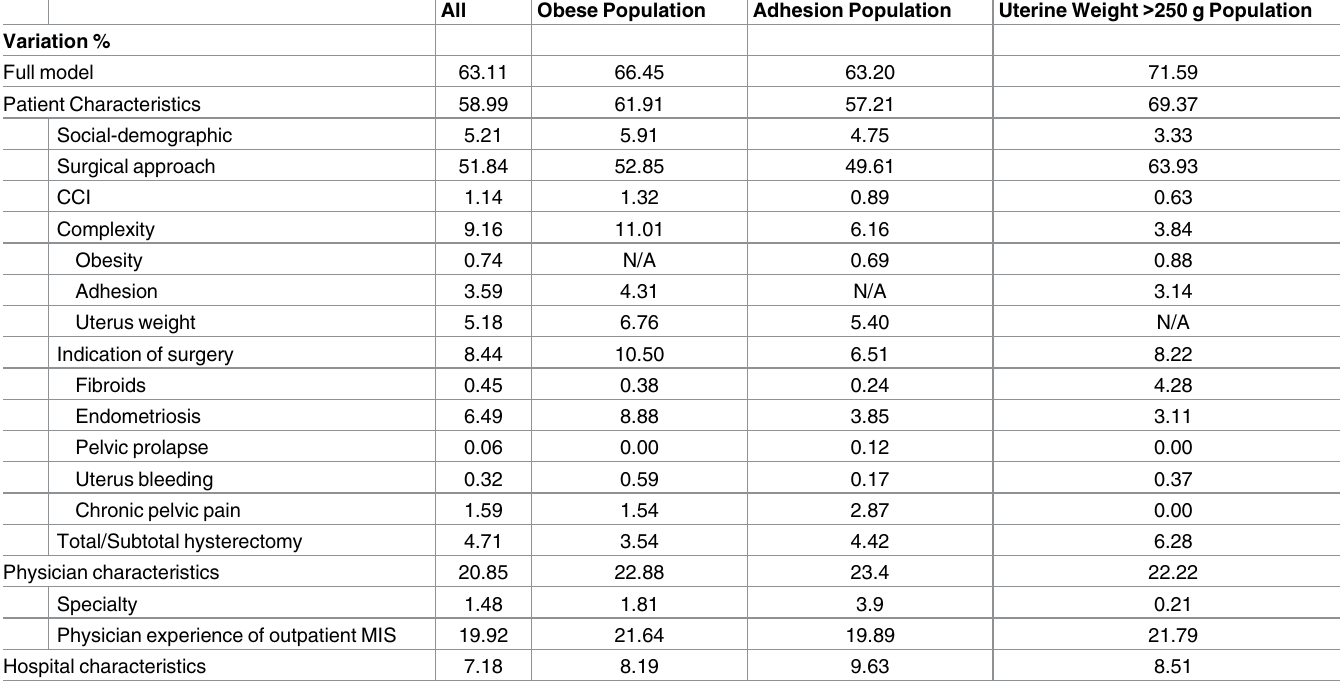
Table 2. Contributions of hospital, surgeon, and patient characteristics to the variation in predicting likelihood of outpatient BH,